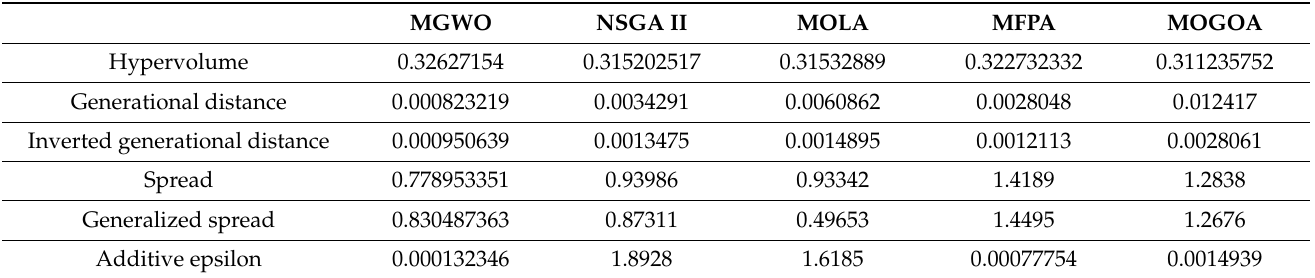
Table 12. Comparative assessment considering different metrics of the compared algorithms for WBD